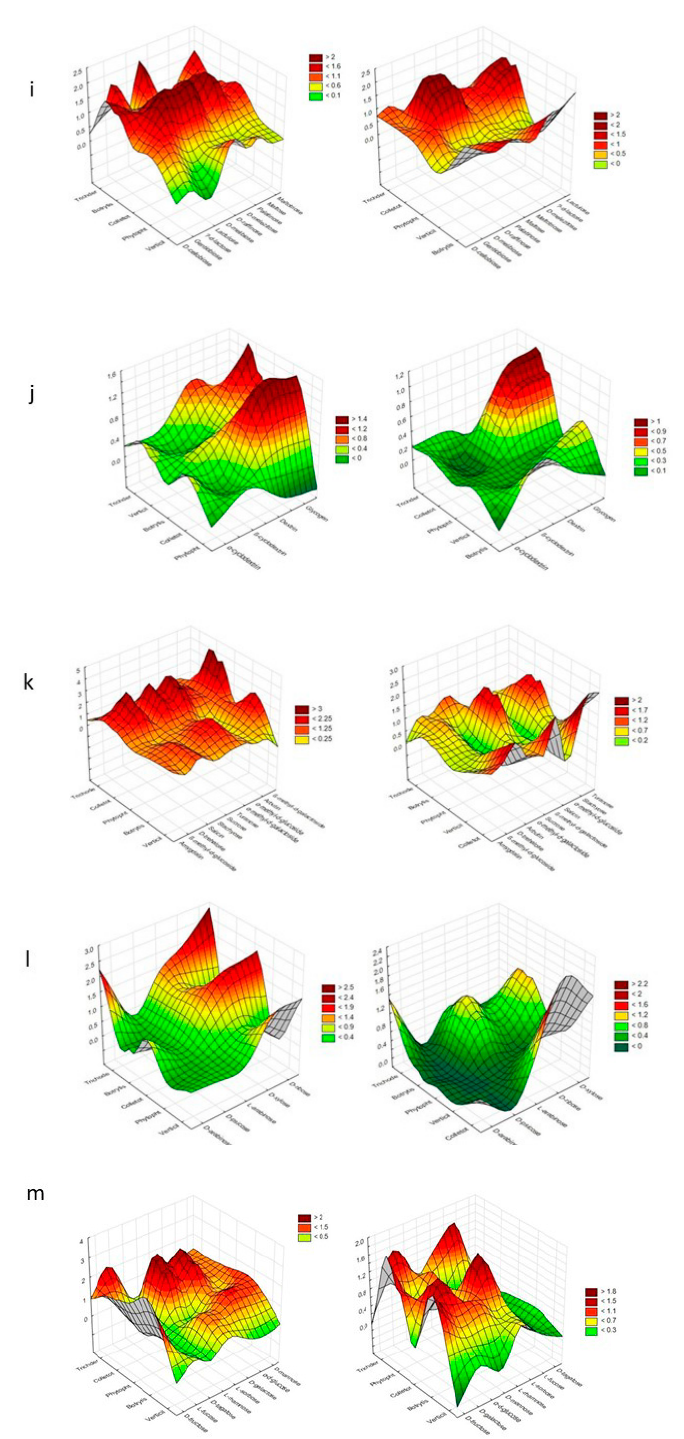
Figure 4. Cluster Analysis depicting the consumption response (A 490 nm, shown at left) and growth response (A 750 nm, shown at right) of microorganisms to substrates located on Biolog ® FF plates, shown as the following substrate groups: ( a ) peptides, (b ) L-amino acids, ( c ) Tricarboxylic Acid (TCA) cycle-intermediates, ( d ) aliphatic organic acids, ( e ) biogenic and heterocyclic amines, ( f ) polyols, ( g ) hexosamines, ( h ) sugar acids, ( i ) oligosaccharides, ( j ) polysaccharides, ( k ) glucosides, ( l ) pentoses, and ( m ) hexoses. The analysis was performed on the basis of consumption (490 nm) and growth potentiates (A > 0.2, n =